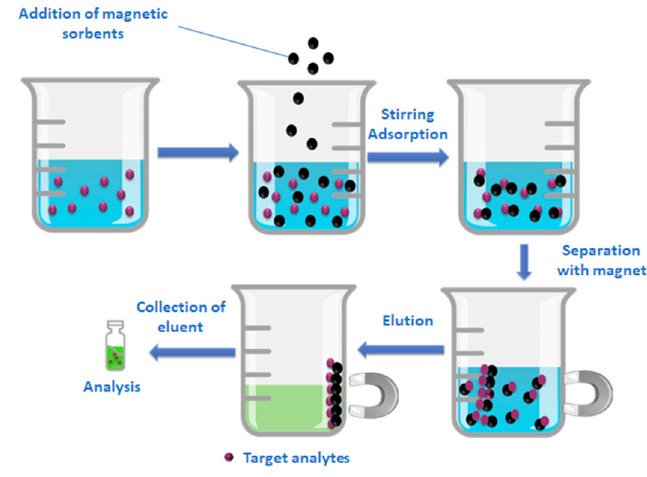
Figure 13. Schematic procedure of MSPE.